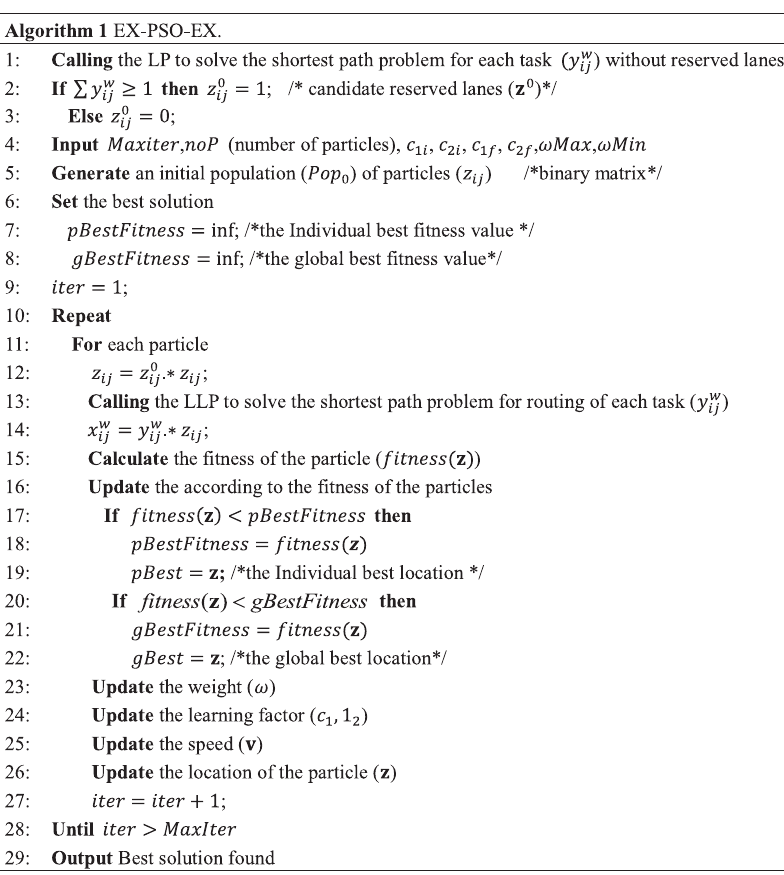
Figure 3: Pseudocode of EX-PSO-EX for